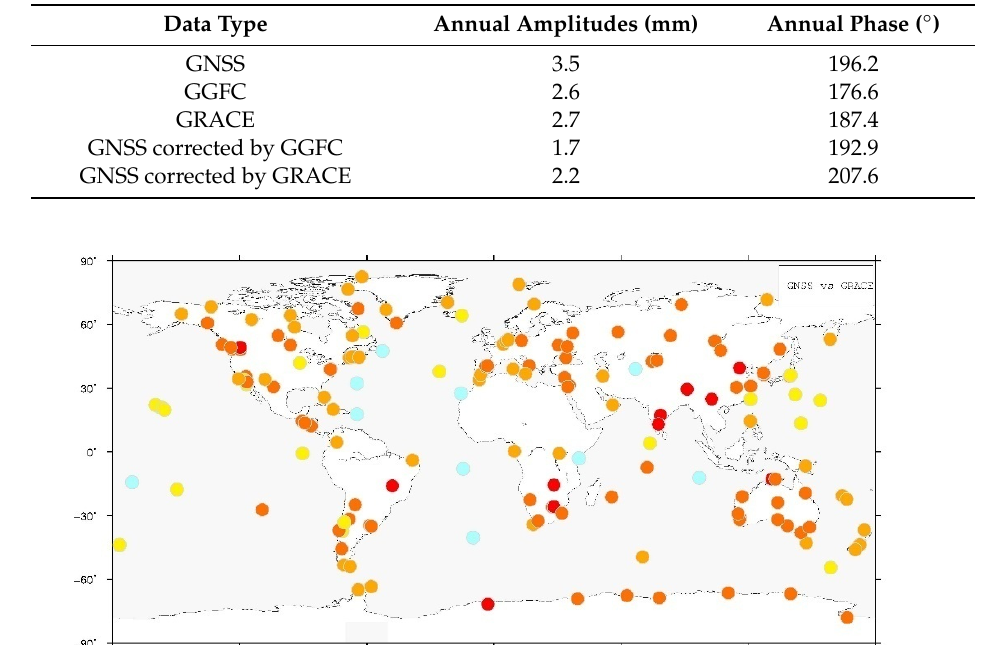
Figure 5. Histogram of statistical results for the correlation coefficients (the red text above the histogram represents the average of the correlation coefficients).